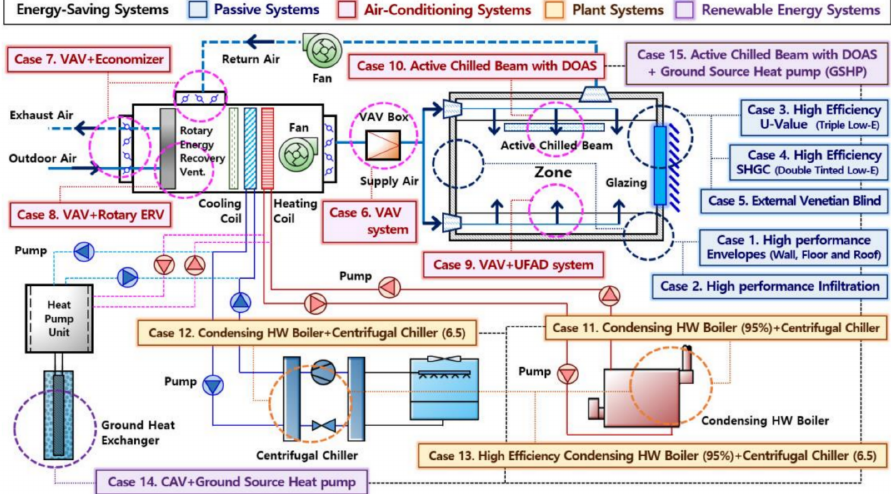
Figure 10. Simplified diagram of energy-saving